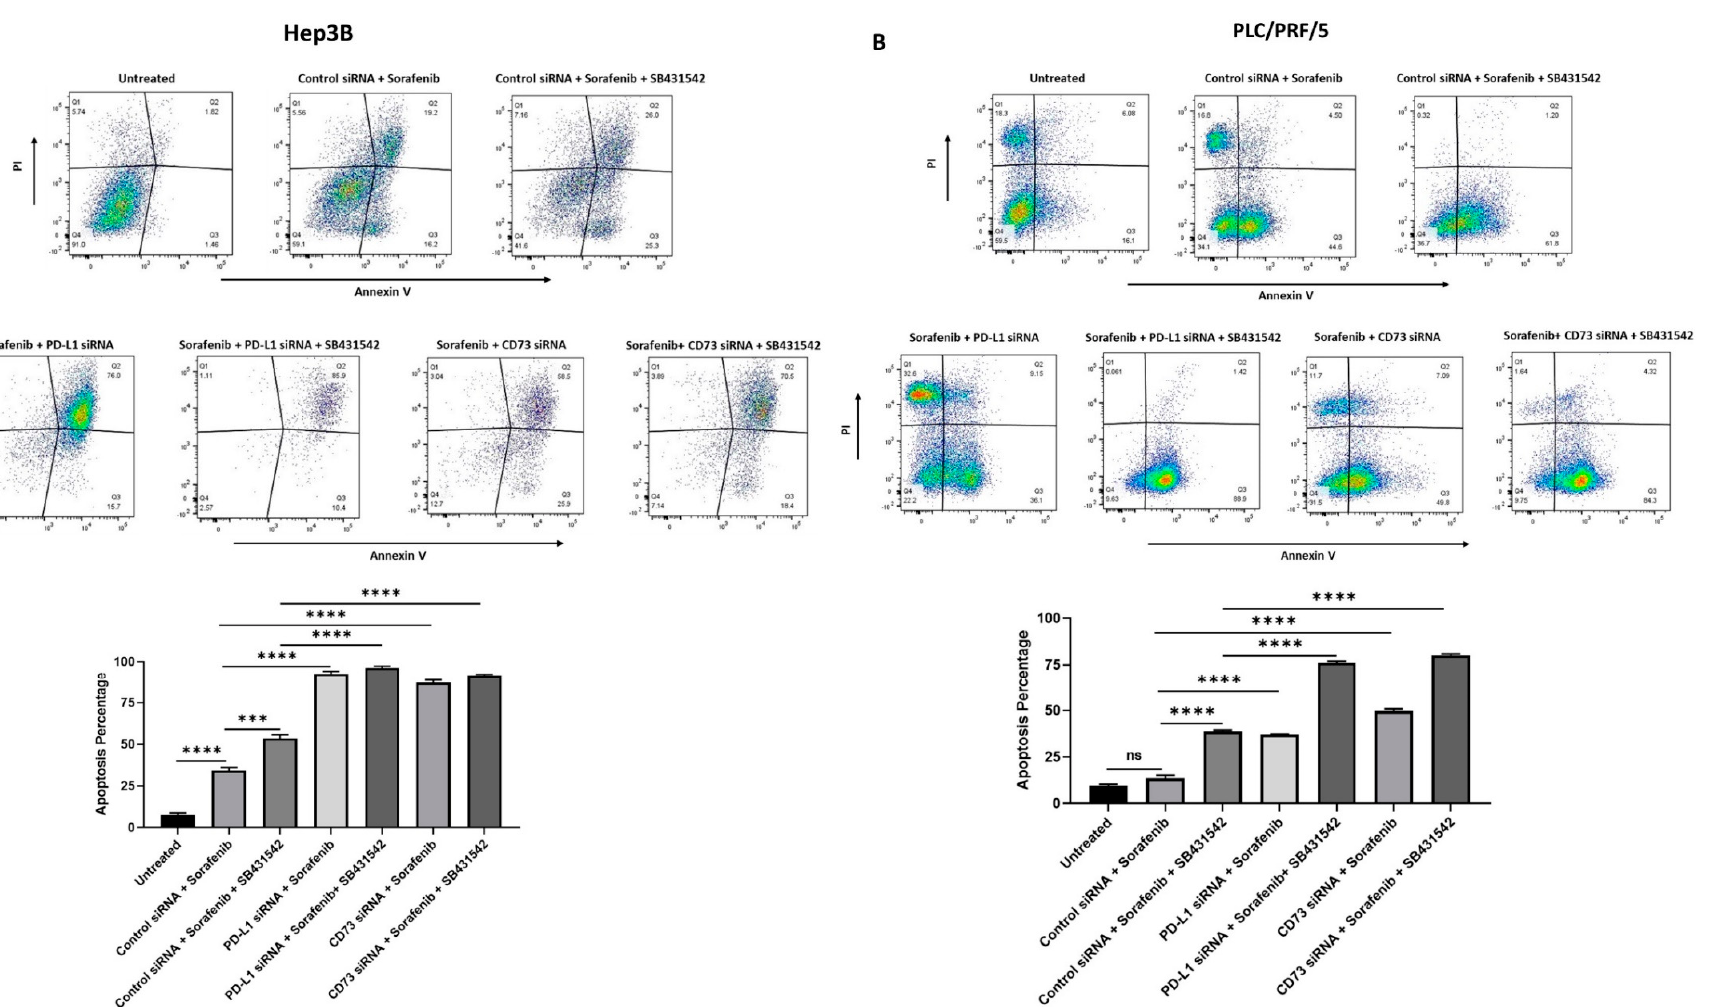
Figure 9. Combined targeting of EMT and immune checkpoint molecules enhanced Sorafenib-induced apoptosis in human HCC-derived spheres. Flow cytometric analysis of Annexin V/Propidium Iodide staining revealed increased percentage of apoptotic cells following combination treatment of Sorafenib with SB431542 and PD-L1 or CD73 siRNA compared to Sorafenib alone in ( A ) Hep3B-derived spheres and ( B ) PLC/PRF/5-derived spheres. ( n = 3, *** p < 0.005, **** p < 0.001, ns: not significant).